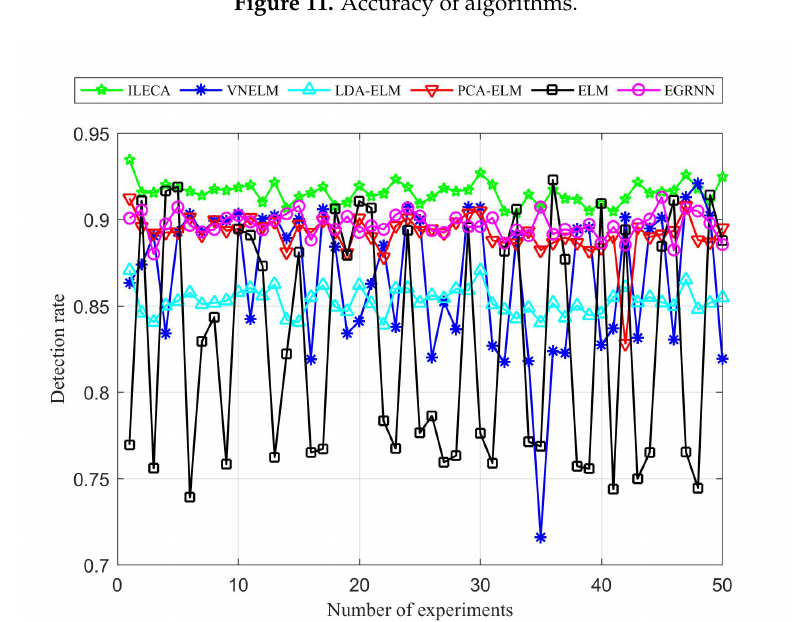
Figure 12. Detection rate of